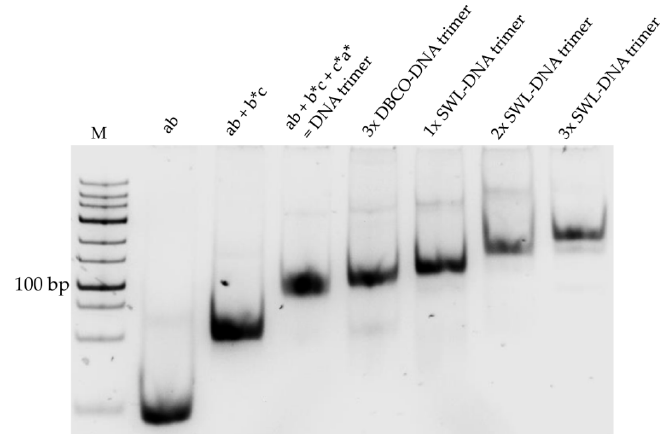
Figure A1. 10% ( v / v ) native PAGE showing the assembly of DNA trimers and addition of SWL peptides. Three partially complementary DNA strands (ab, b *c and c *a *) were self-assembled to DNA trimers (ab + b *c + c *a * = DNA trimer). Trimers were modified with three DBCO molecules (3 × DBCO-DNA trimer) for the addition of three SWL peptides (3xSWL-DNA trimer). By mixing DBCO- and unmodified strands, trimers containing 1xSWL (1xSWL-DNA trimer) and 2xSWL (2xSWL-DNA trimer) were produced. PAGE gel was stained with SYBR ® Gold Nucleic Acid Gel Stain (Thermo Fisher